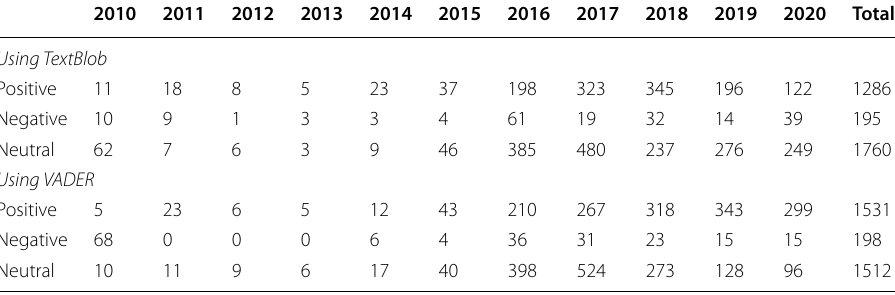
Table 12 The polarity frequency of the tweets over the years 2010–2020